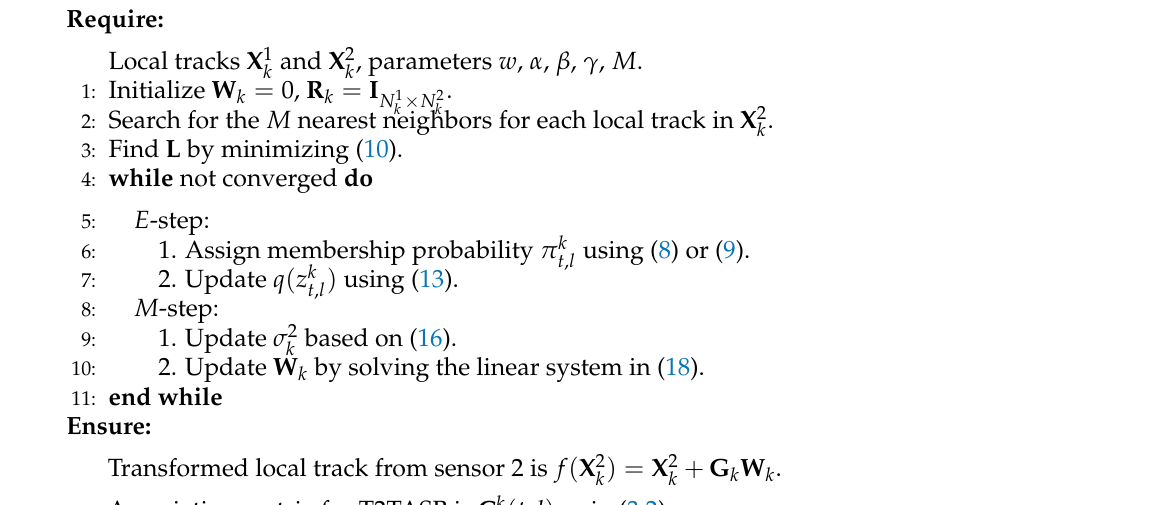
Algorithm 1 Proposed LTGP method for